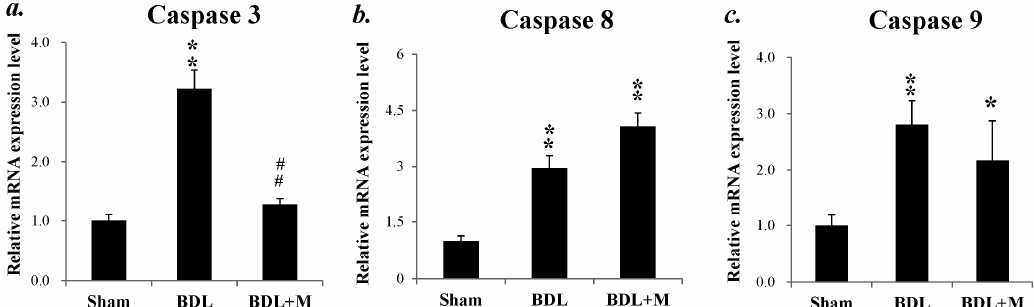
Figure 3. mRNA expression of caspase 3, 8 and 9: ( a ) expression of caspase 3 mRNA was increased in BDL group and down-regulated in BDL + M group; ( b ) BDL group had higher caspase 8 mRNA than Sham group; and ( c ) caspase 9 mRNA was increased in BDL and BDL + M groups. Significant difference among three groups was analyzed by one-way ANOVA followed by Bonferroni post hoc. All data are shown as mean ± SEM. * p < 0.05 vs. Sham; ** p < 0.01 vs. Sham; ## p < 0.01 vs. BDL. In addition, Western blot revealed increased protein expression of cleaved caspase 3, 8 and 9 in BDL group (cleaved caspase 3 (F (2, 14) = 6.559, p = 0.010); cleaved caspase 8 (F (2, 14) = 15.469, p < 0.001); cleaved-caspase 9 (F (2, 13) = 6.431, p = 0.011)), and melatonin treatment significantly reduced